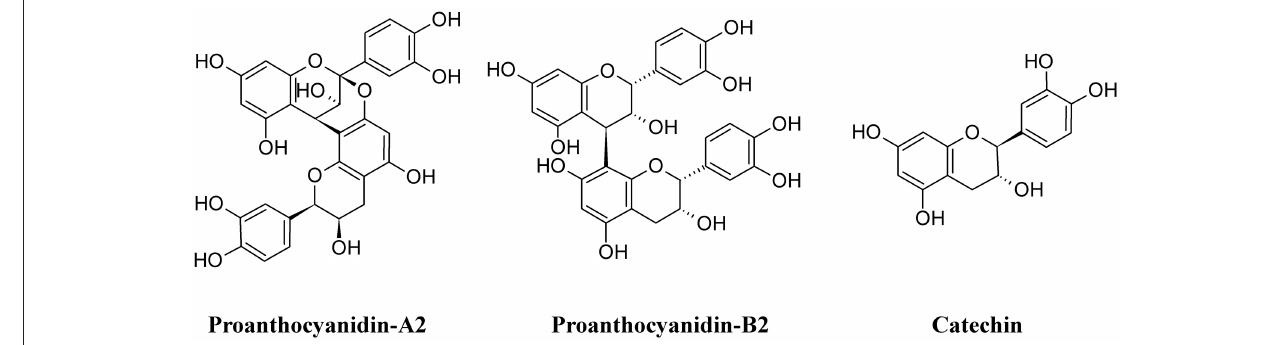
FIGURE 9 | Structure formulae of some polymeric phenolics.